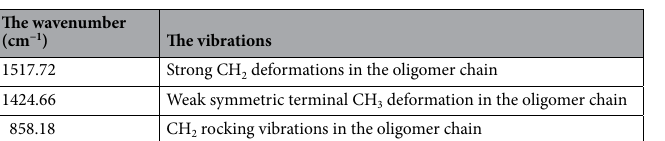
The wavenumber (cm −1